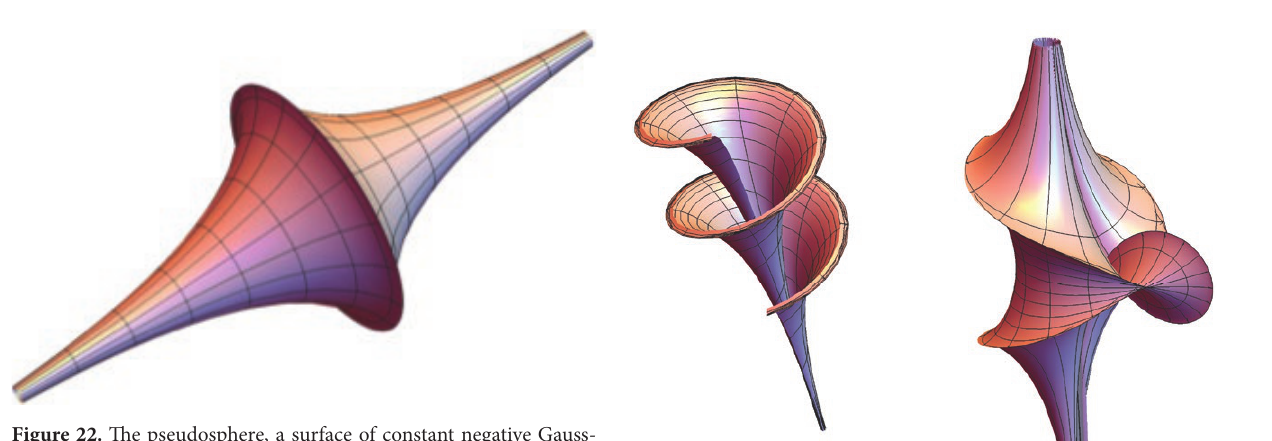
Figure 22. Th e pseudosphere, a surface of constant negative Gauss- ian curvature.